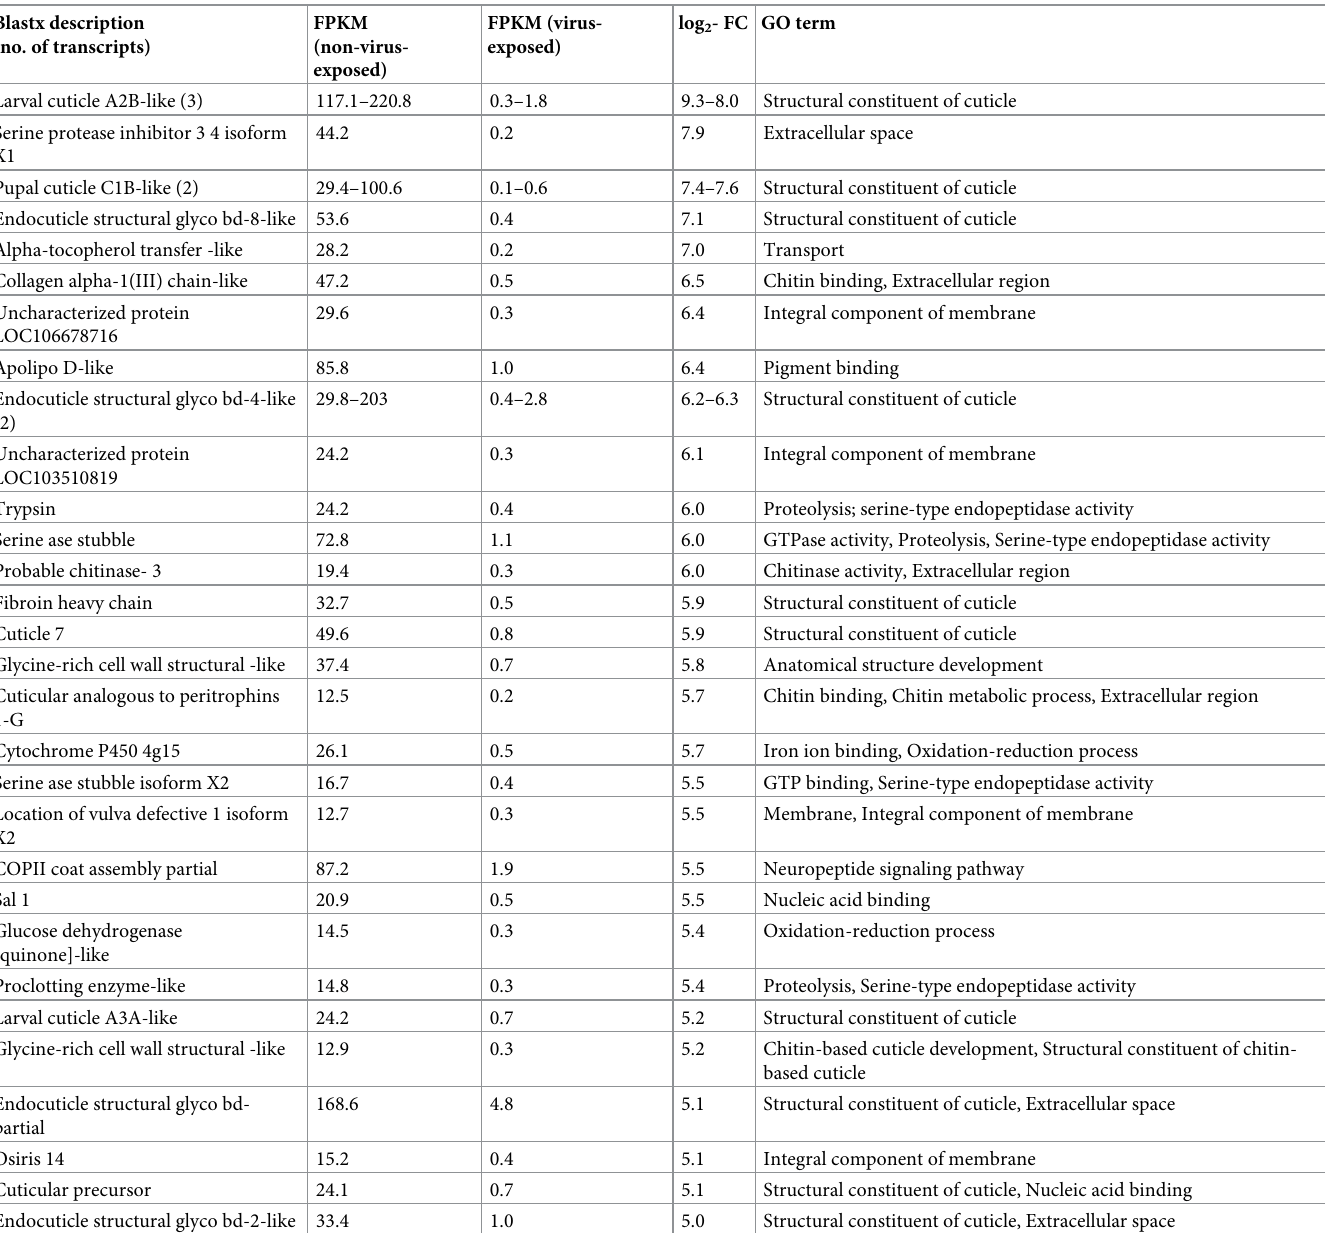
Table 3. List of significantly down-regulated DE (q < 0.01, log 2 -FC > 1.0, FPKM > 10) transcripts in CaCV-exposed and non-exposed Thrips palmi transcriptome. Blastx description (no. of